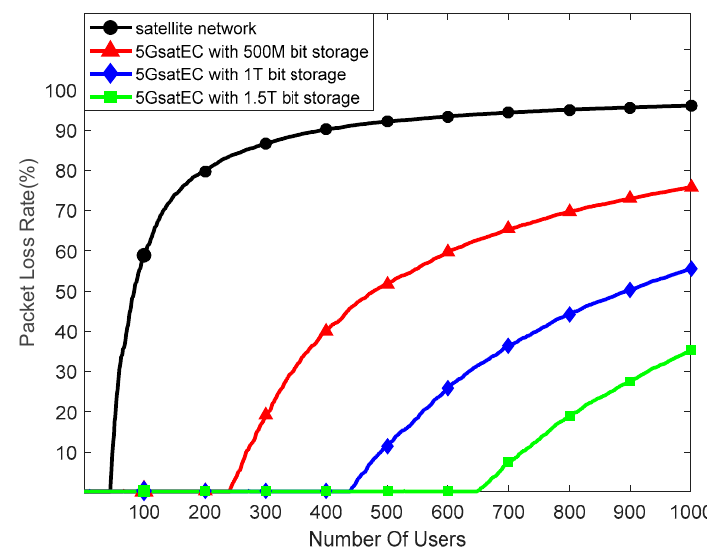
Figure 10. Packet loss rate between the satellite network and 5GsatEC.